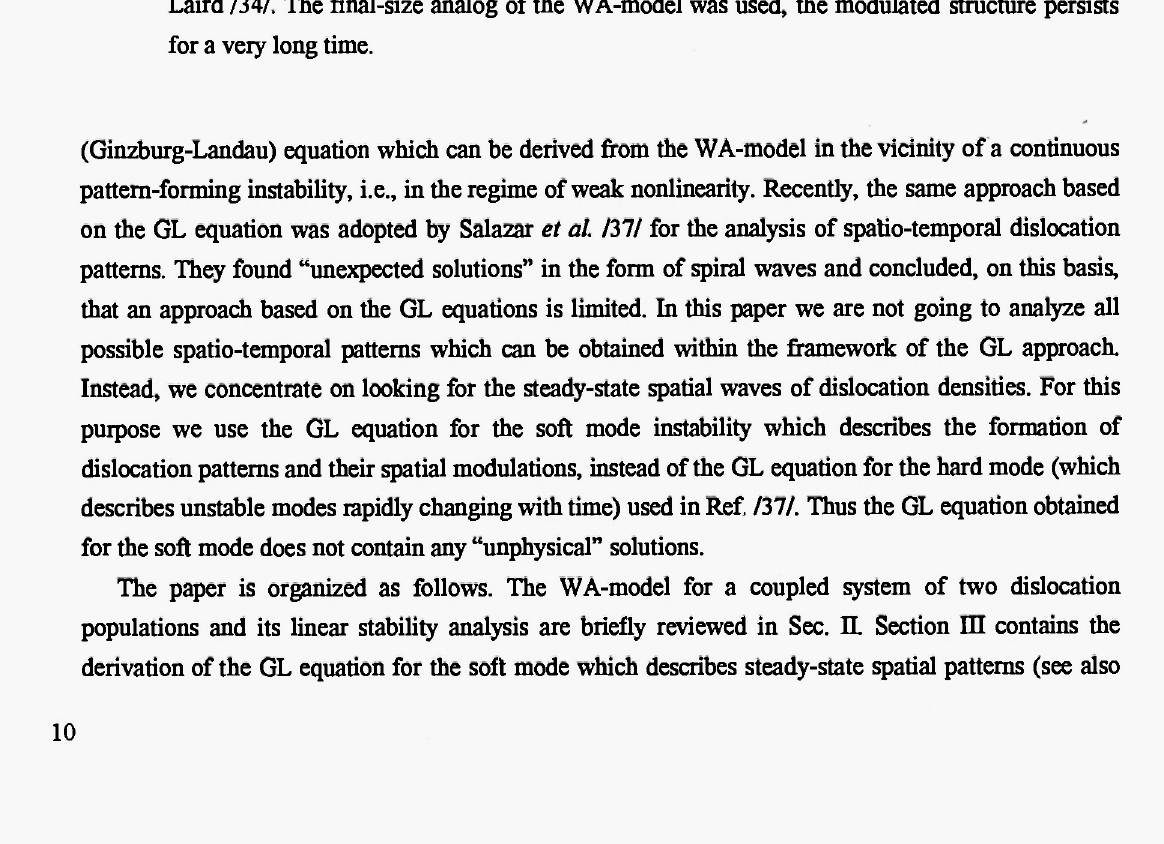
Fig. 2: The density of immobile dislocations, X, as a function of scaled length, x/L, for a one- dimensional "grain" (grain size L = 13 μιη) obtained in numerical simulations by Glazov and Laird /34/. The final-size analog of the WA-model was used, the modulated structure persists for a very long